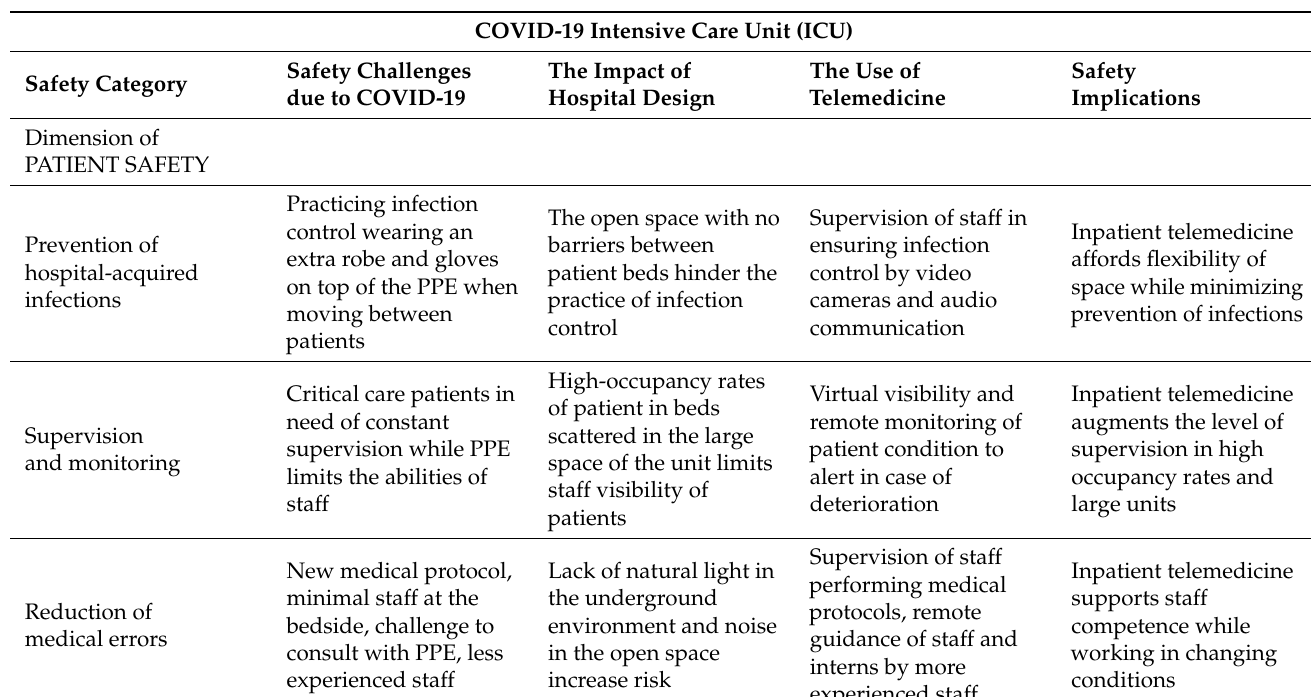
Table 2. The impact of inpatient telemedicine on patient and staff safety in the COVID-19